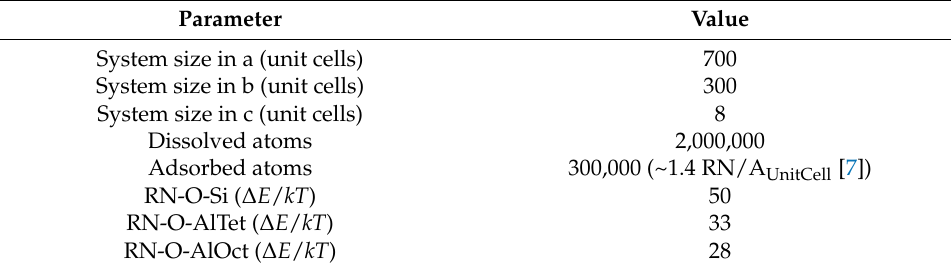
Table 1. KMC simulation parameters used in all